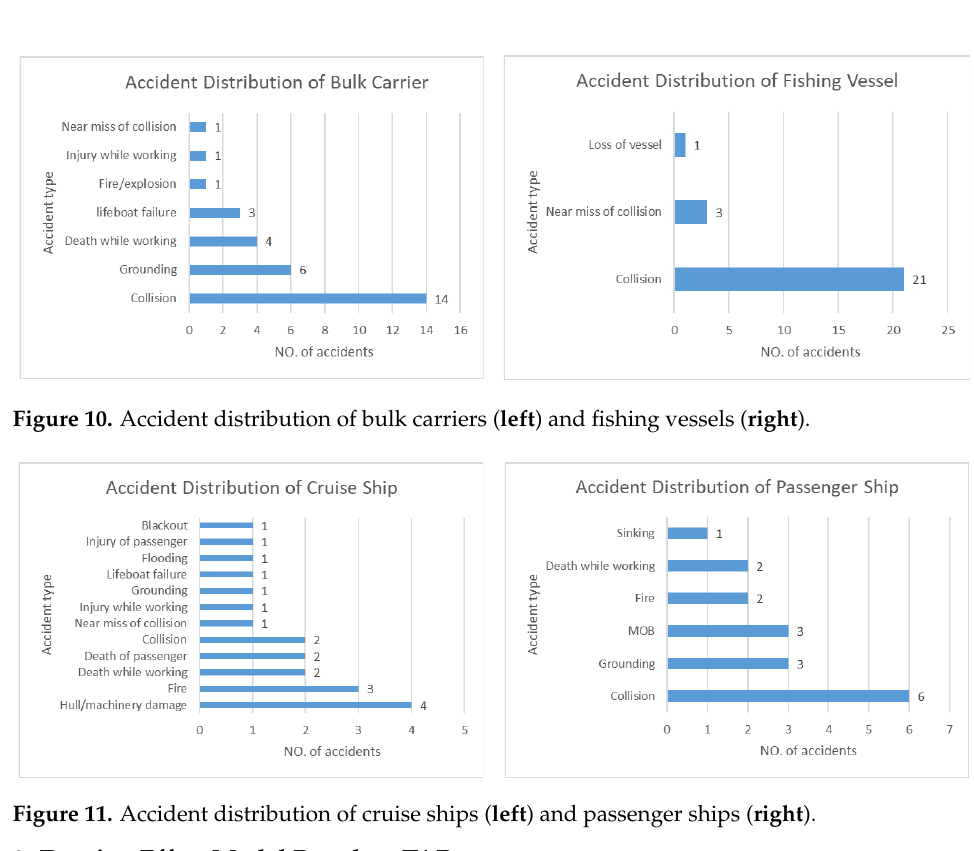
Figure 11. Accident distribution of cruise ships ( left ) and passenger ships ( right ).